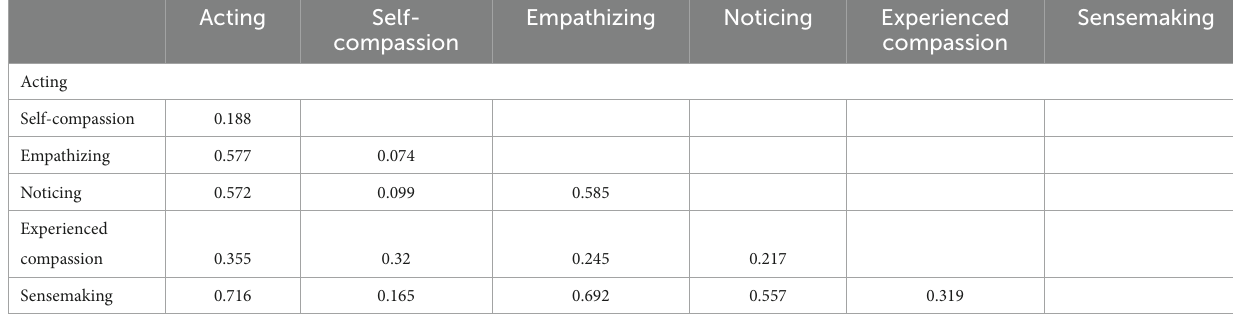
TABLE 10 HTMT assessment of discriminant validity analysis for differentiating other related constructs ( N =